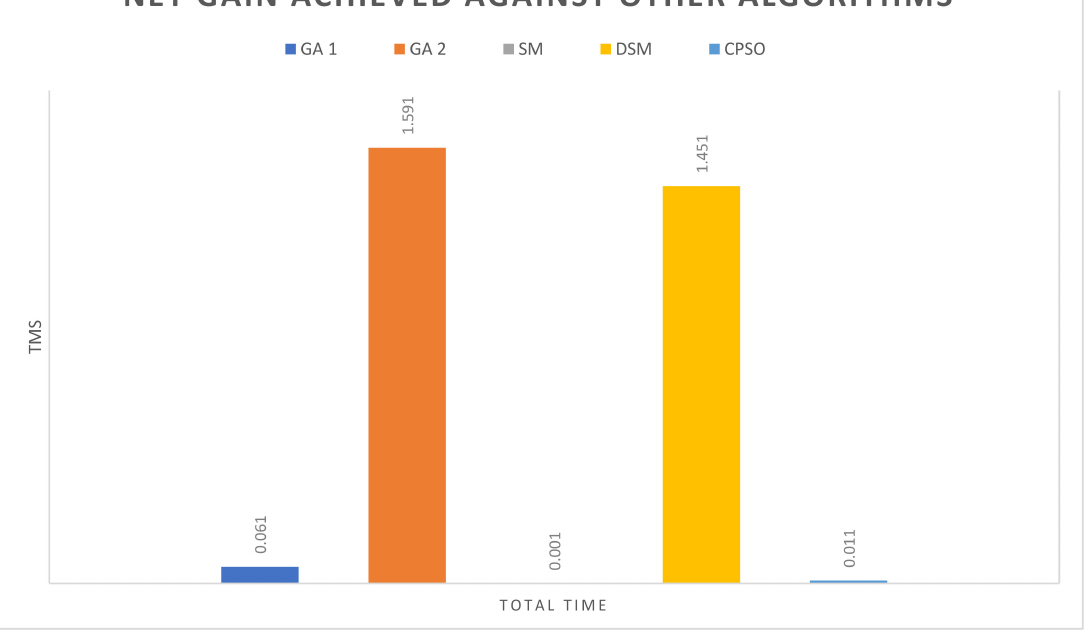
Figure 4. Comparison analysis of HPSO with other algorithms (Case 1).